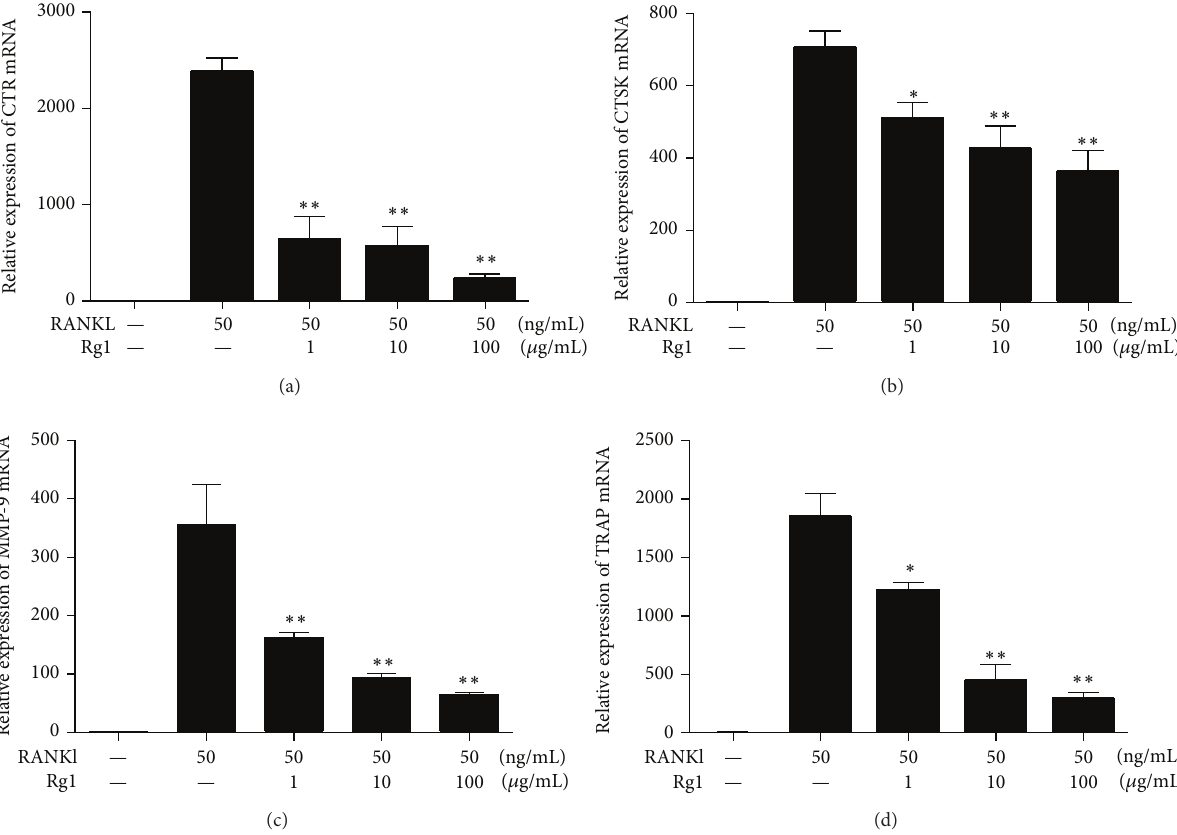
Figure 3: Effect of Rg1 on the mRNA expression of osteoclastic marker genes in RANKL-stimulated RAW 264.7 cells. RAW 264.7 cells (2 × 10 4 cells/mL) were stimulated with RANKL (50ng/mL) in the presence of Rg1 (1, 10, and 100 𝜇 g/mL) for 96 h in 12-well plates. mRNA expressions of osteoclastogenic marker genes were determined by RT-PCR. Values are expressed as the mean ± SD of triplicate experiments. ∗ 𝑃 > 0.05 , ∗∗ 𝑃 < 0.01 , and ∗∗∗ 𝑃 < 0.001